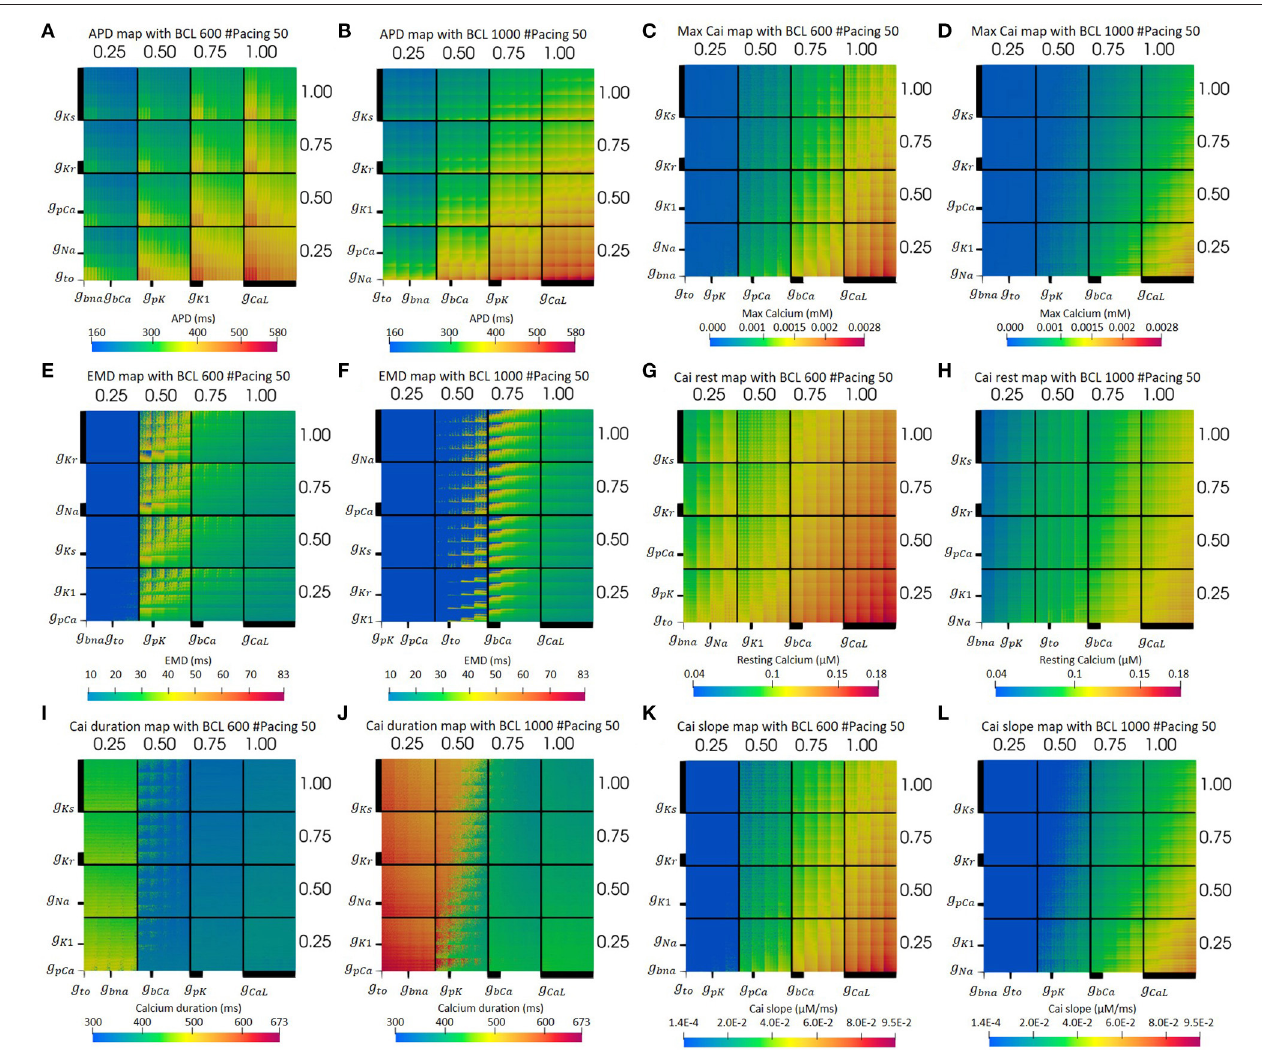
FIGURE 3 | The optimum dimensional stacking for both BCL 600ms (A,C,E,G,I,K) and BCL 1,000ms (B,D,F,H,J,L) . Note that the bold line on each axis indicates the scale of each conductance variation. The biggest axis scale is 1/4 of the main axis, such as the CaL channel. The smaller one will have 1/4 the size of the bigger axis next to it. For (E,F) , the bold blue dots on the left part of the map are for no-contraction cases.